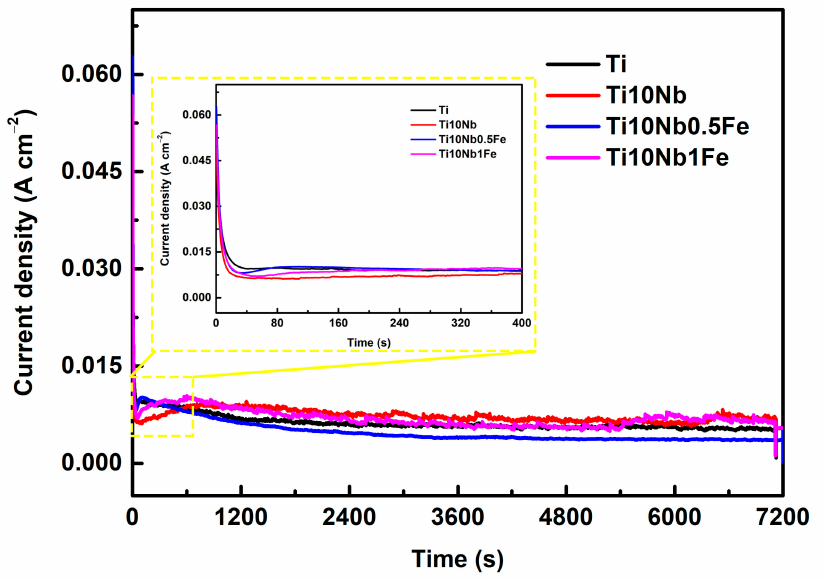
Figure 2. The current density of different alloys during different reaction times. The inset image shows the local regions for the first 400 s, in which the three stages are